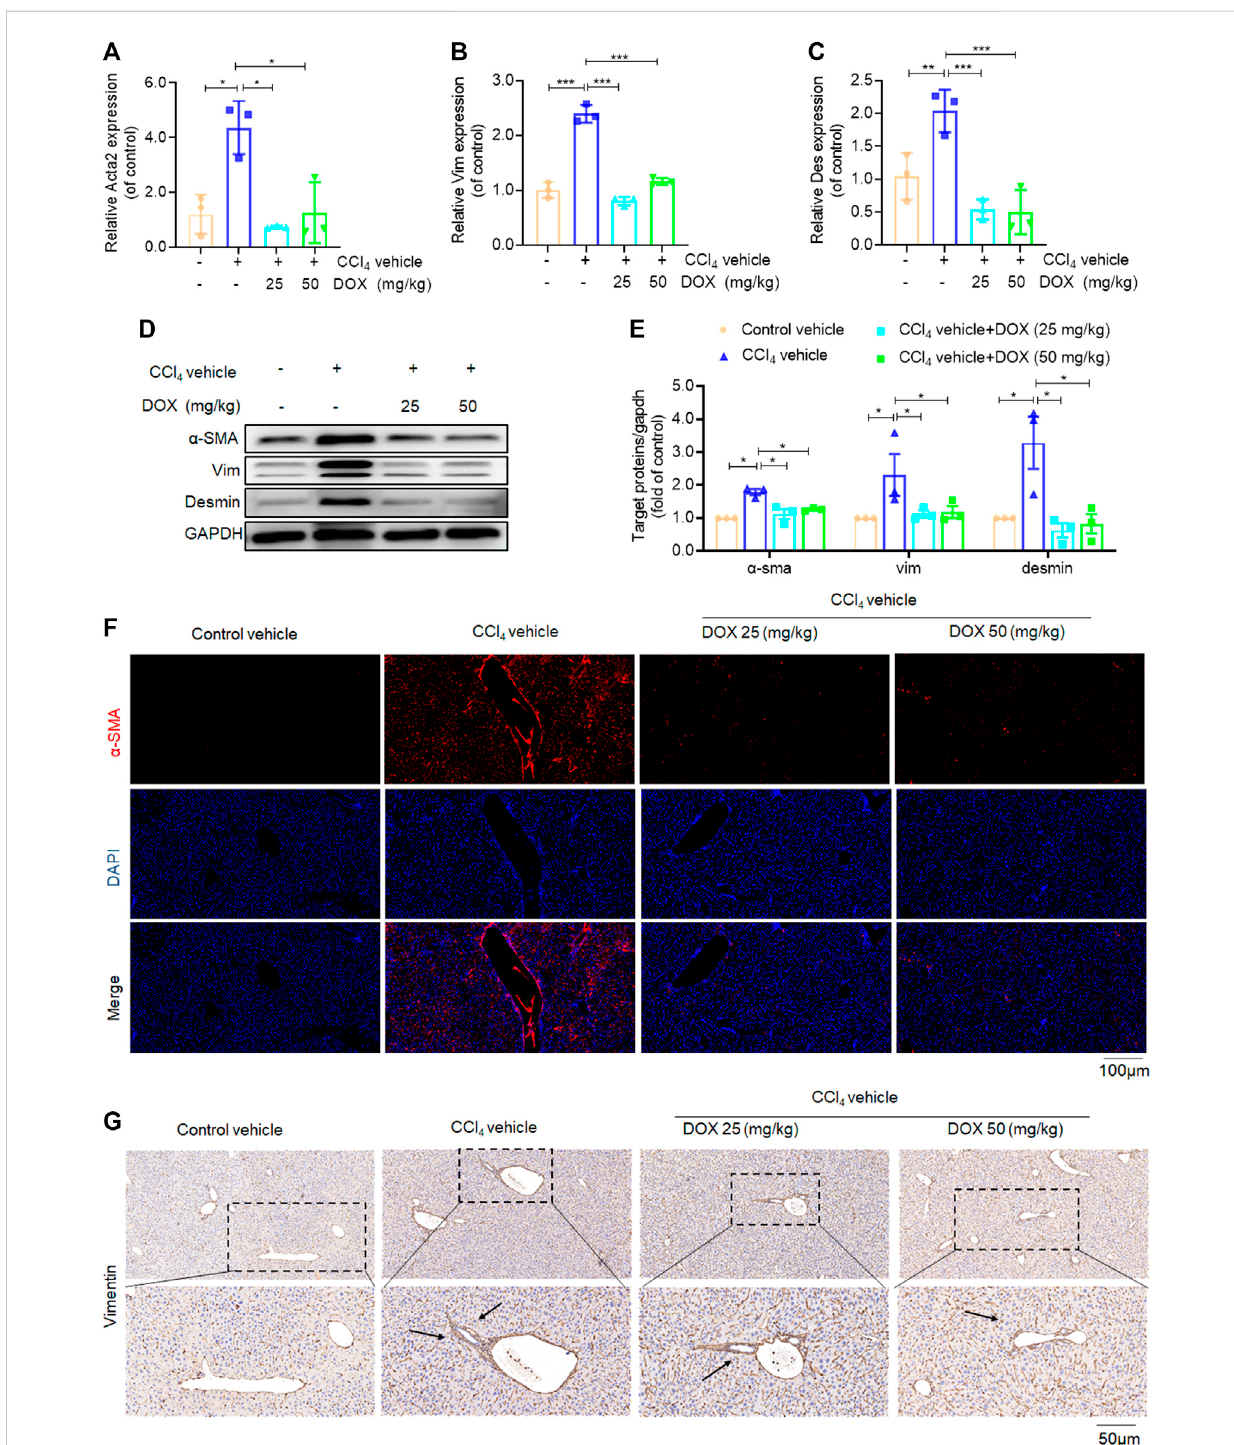
FIGURE 3 EffectsofDOXonHSCsactivation invivo . (A – C) LiverActa2( α -SMA),Vim(Vimentin),Des(Desmin)mRNAexpression( n =3). (D,B) Theexpressionof α -SMA,vimanddesminproteinsinCCl 4 -inducedmicelivertissuestreatedwithDOX(25,50 mg/kg)wasdetectedbyWesternblot,andGAPDHwasused as a loading control. (E) The quantitative result of α -SMA, vim and desmin. The results represent three independent experiments. (F) Liver α -SMA immuno fl uorescence staining (original magni fi cation×100). (G) Liver Vim immunohistochemical staining (original magni fi cation×100). Typical images are chosen from each experimental group. Black arrows indicate positive staining. Data were expressed as means ± SEM. * p < 0.05; ** p < 0.01; *** p <